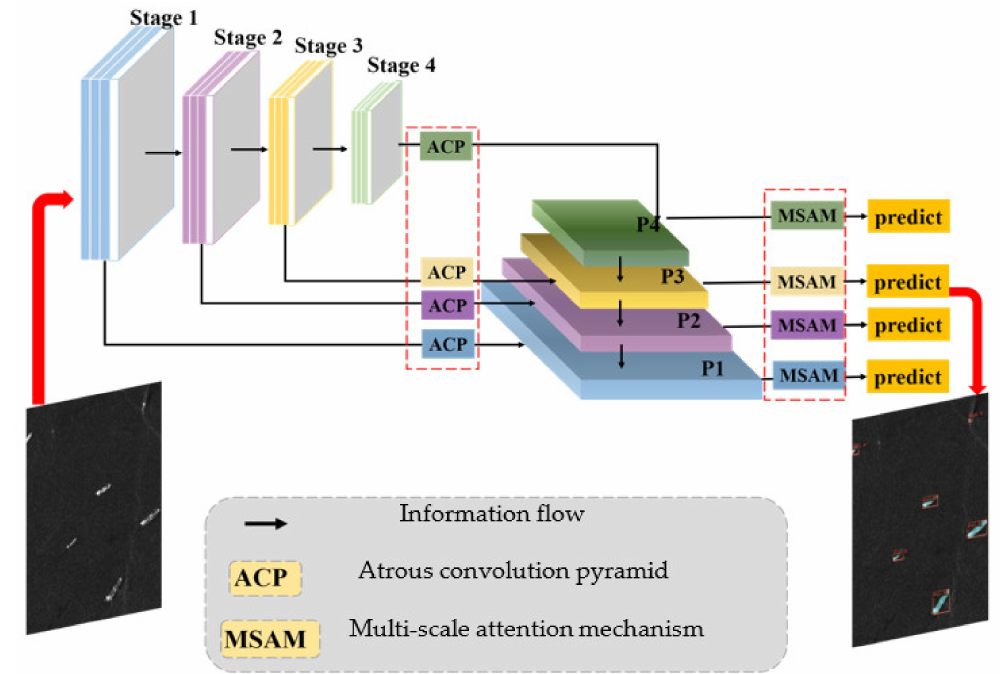
Figure 5. The flow chart of the proposed method. The core idea of this method is to embed ACP and MSAM into FPN, where ACP represents our proposed atrous convolution pyramid, and MSAM represents our proposed multi-scale attention mechanism module. The red dotted box represents our